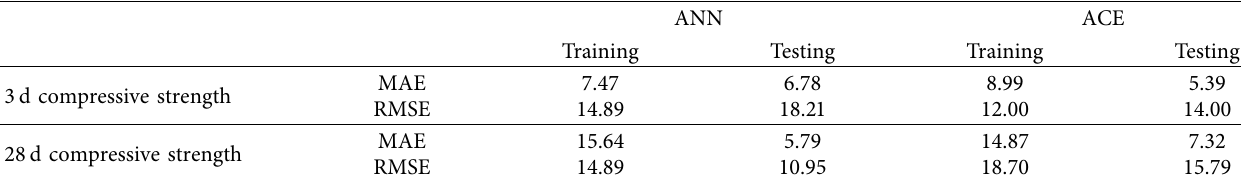
Table 6: Error evaluation